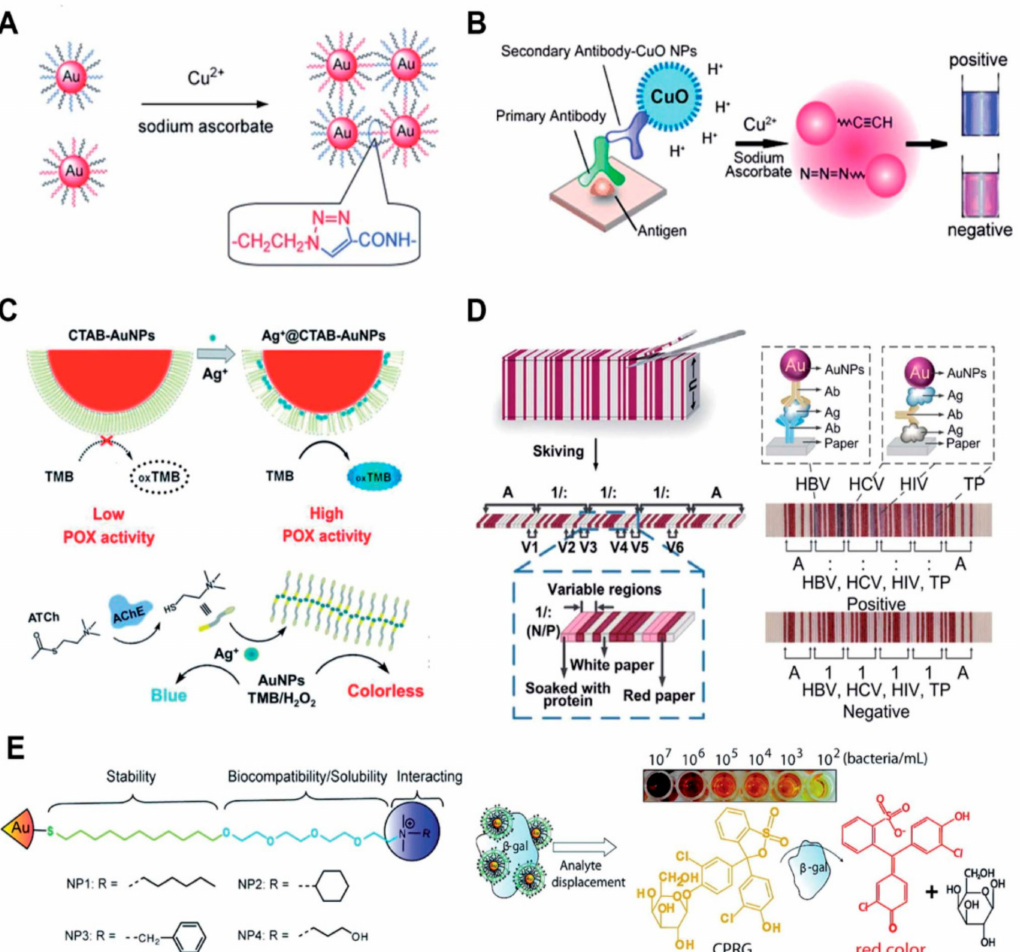
Figure 52. Au NPs allow sensing and diagnostic surface chemistry. ( A ) The 1,3-diogravic azide and alkyne (CuAAC) catalyzed Cu(I) occurs at the Au NP surface, which is the product of Au NPs being aggregated. Copyright 2008 Wiley-VCH, reproduced with reference permission [213] ( B ) CuAAC-based colorimetric immunoassay occurs on an Au NP